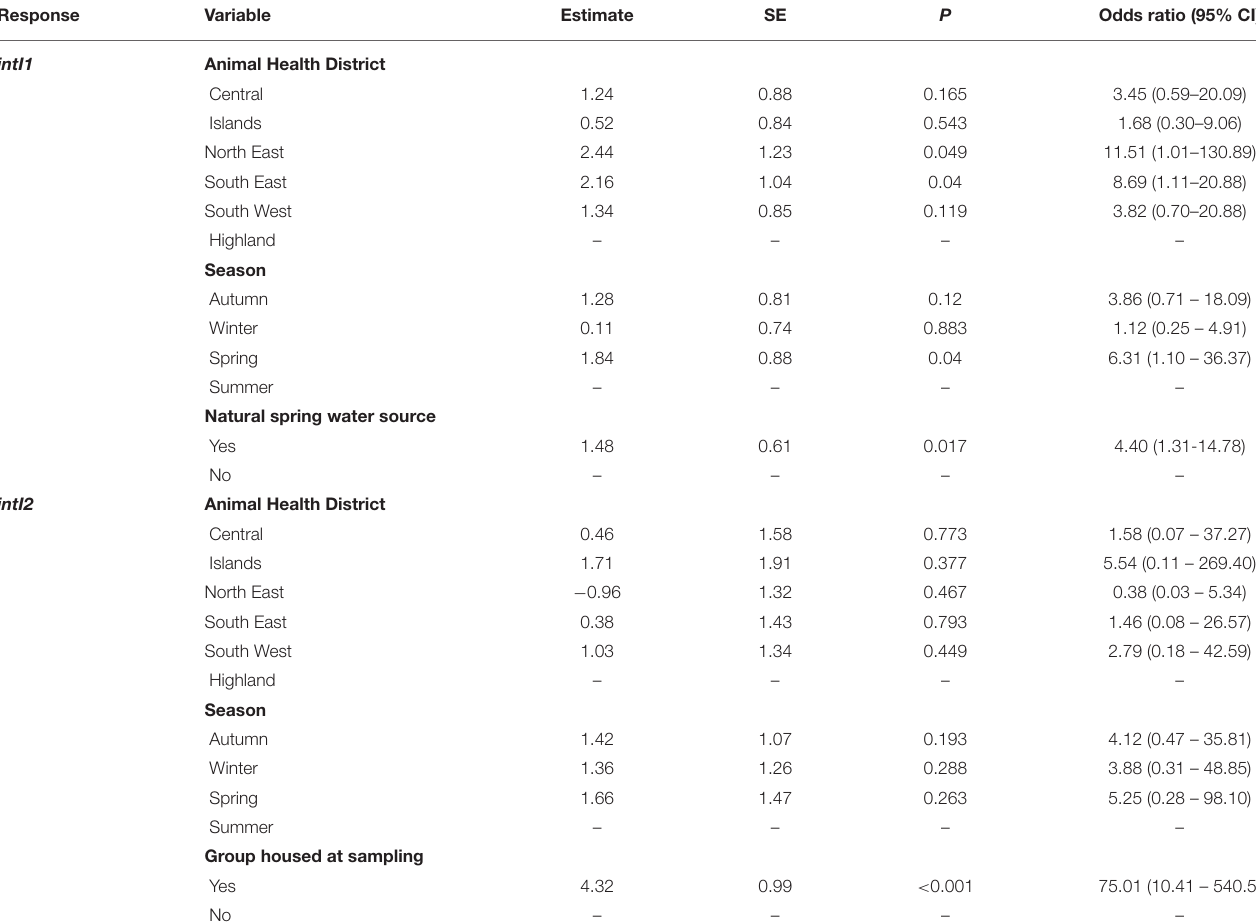
TABLE 3 | Results of the multivariable generalized linear mixed model, showing region, season and herd management variables for herd intI1 and intI2 PCR-positive status, given as odds ratio with 95% confidence interval (CI).